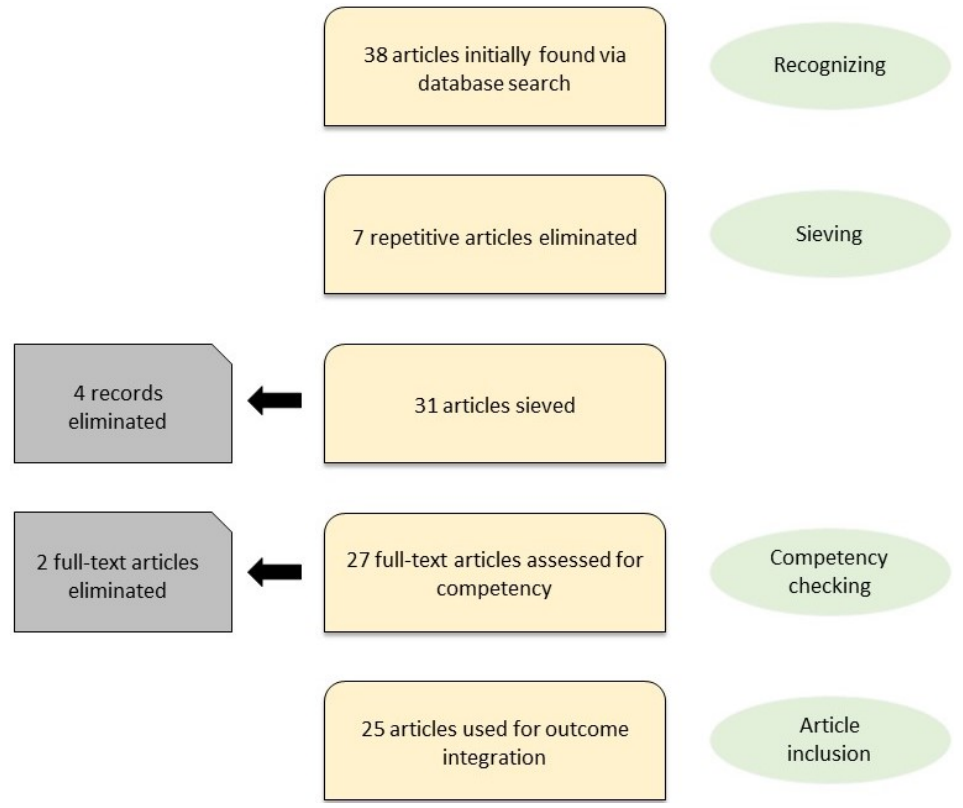
Figure 1. The process of extracting relevant papers based on the diverse combination of important search expressions.